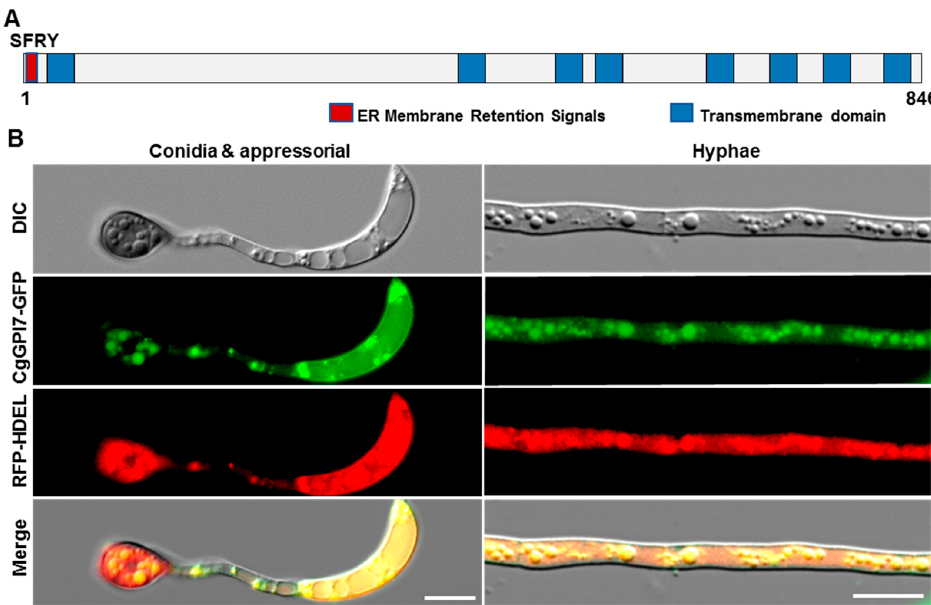
Figure 4. CgGPI7 located in the endoplasmic reticulum in C. graminicola . ( A ) Subcellular localization prediction showed CgGPI7 protein harboring an ER membrane retention signal at the N-terminal of the amino acid sequence. ( B ) CgGPI7-GFP and the ER marker RFP-HDEL were co-located at the ER in the conidia, the appressorium, and the vegetative hyphae of C. graminicola . Scale bars = 10 μ m.